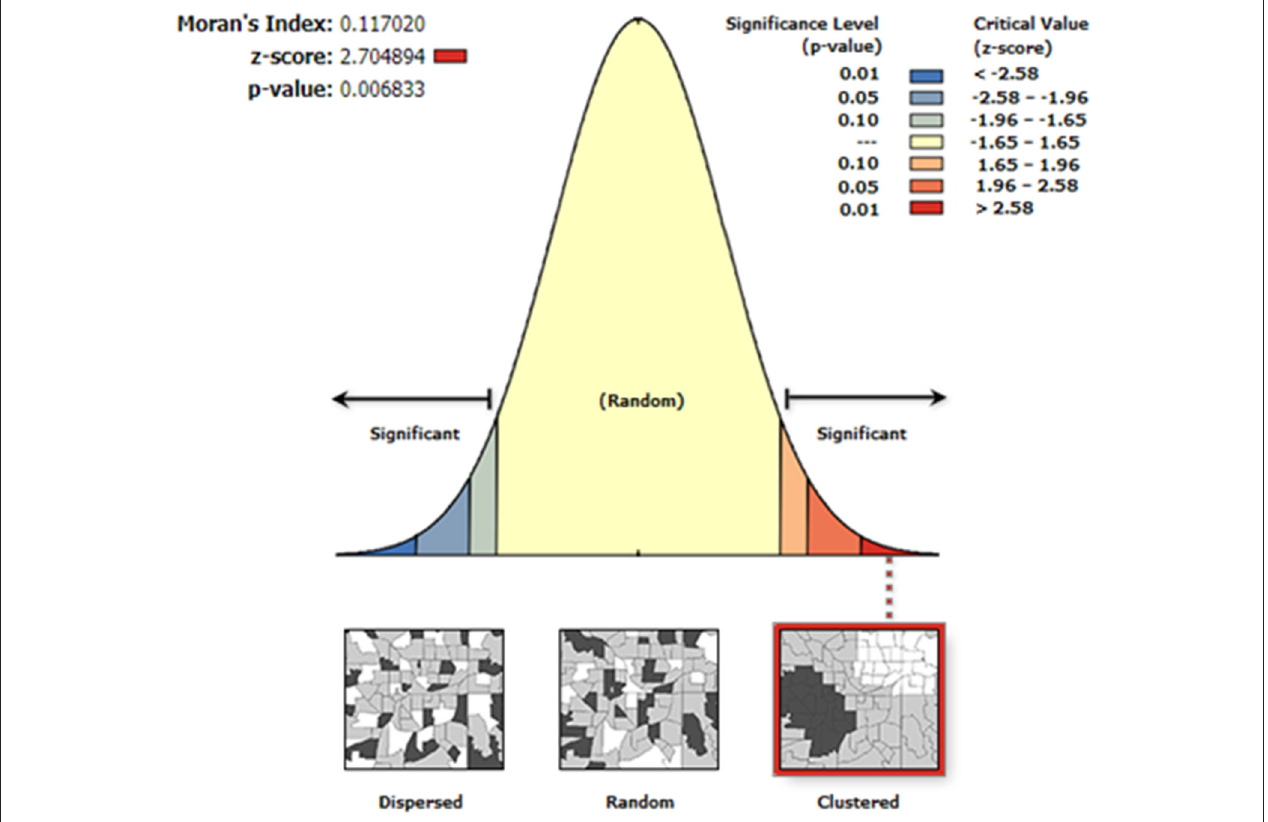
FIGURE 5 | Autocorrelation analysis results for the late-hot-dry season showing a < 1% likelihood that the similarity in tick counts between neighboring crushes could be a result of random chance and, hence, significant.